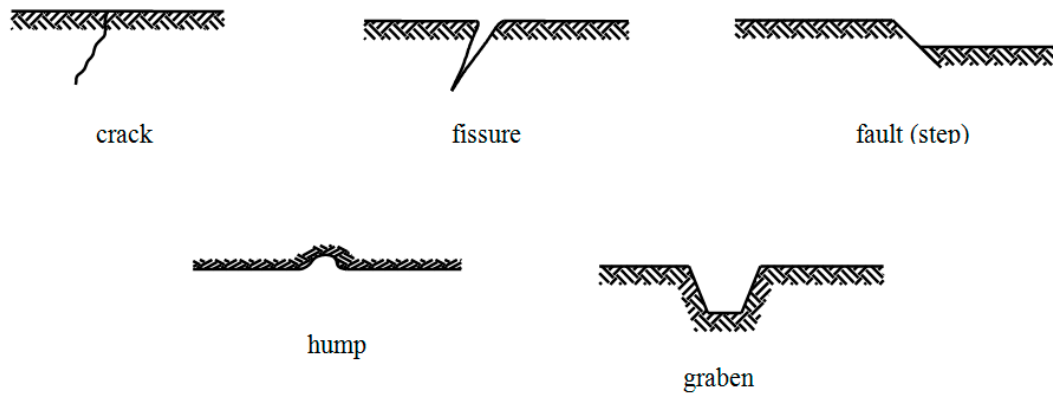
Figure 1. Forms of linear discontinuous deformations [6,7].